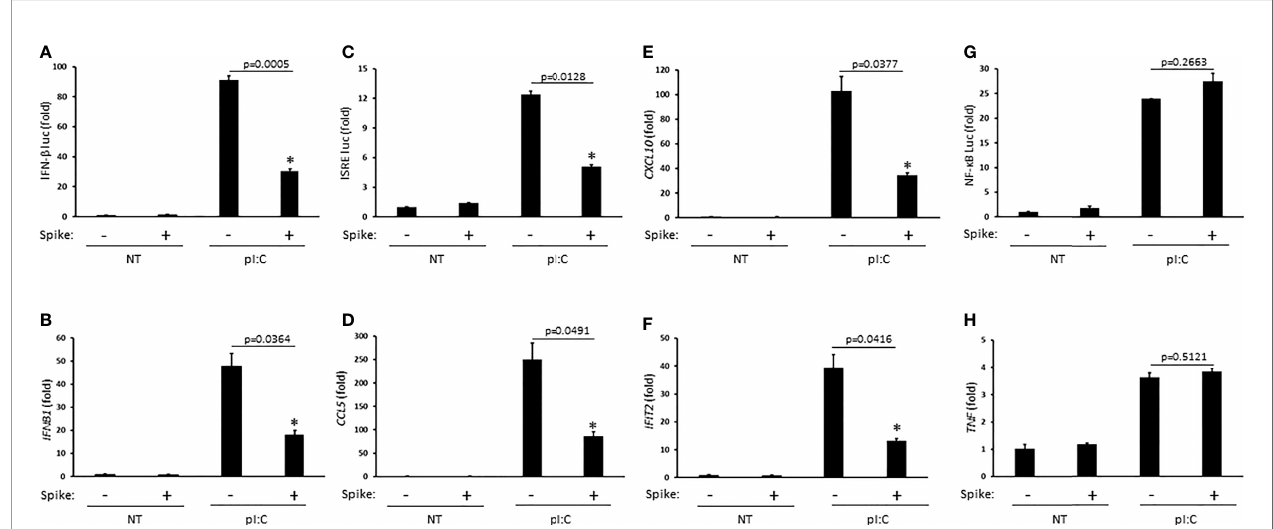
FIGURE 1 | SARS-CoV-2 Spike inhibits pI:C dependent activation of interferon. (A) IFN- b luciferase reporter assay in HEK 293T cells co-transfected with pI:C (1 m g) and C9 Spike (1 m g). (B) Gene expression levels of IFNb1 determined via Q-PCR in HEK 293T cells co-transfected with pI:C and C9 Spike as in (A) . (C) ISRE luciferase reporter assay in HEK 293T cells co-transfected with pI:C and C9 Spike as in (A) . (D – F) Gene expression levels of CCL5 , CXCL10 , and IFIT2 determined via Q-PCR in HEK 293T cells as in (B) . (G) NF- ĸ B luciferase reporter assay in HEK 293T cells co-transfected with pI:C and C9 Spike as in (A) . (H) Gene expression